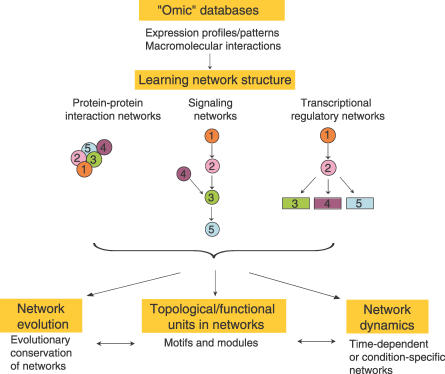
An Overview of Biological Network Analyses Based on “Omic” DataRecent high-throughput technologies have produced massive amounts of gene expression, macromolecular interaction, or other type of “omic” data. Using a computational modeling approach, the architecture of cellular networks can be learned from these “omic” data, and topological or functional units (motifs and modules) can be identified from these networks. Comparisons of cellular networks across different species may reveal how network structures evolve. In particular, the evolutionary conservation of motifs and modules can be an indication of their biological importance. A dynamic view of cellular networks describes active network components and interactions under various conditions and time points. Network motifs and modules can also be time-dependent or condition-specific.